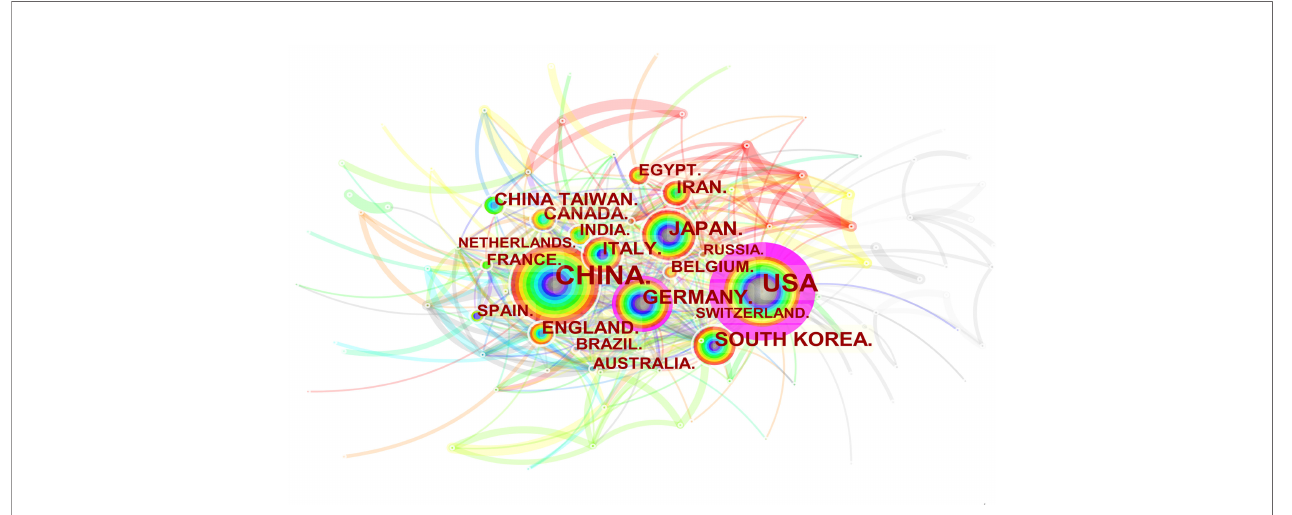
FIGURE 3 | Spatial distribution map of countries/regions. The size of the node re fl ects the frequencies, and the links indicate the collaboration relationships. The color of the node and line represent different years. The outermost purple ring represents the centrality level, and the nodes with high centrality are considered to be the key points in the research fi eld.